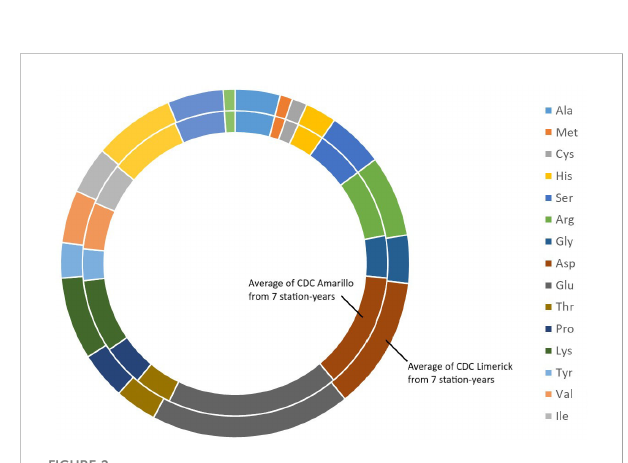
FIGURE 2 Average amino acids pro fi le of CDC Amarillo and CDC Limerick from 7 station-years.